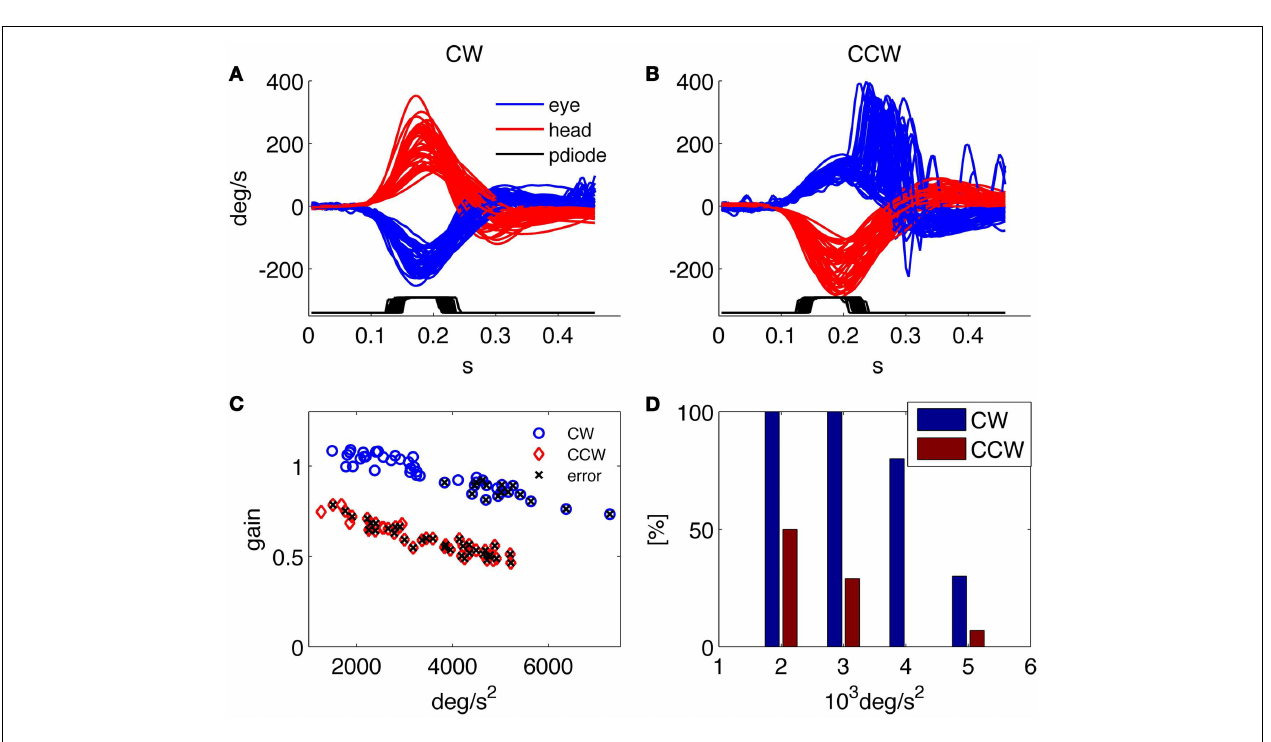
FIGURE 4 | Results of the HITD test on a patient with vestibular neuritis (left side deficit) . (A,B) Head and eye movement for CW and CCW rotations, respectively. (C) Plot ofVOR gain values computed for each movement,